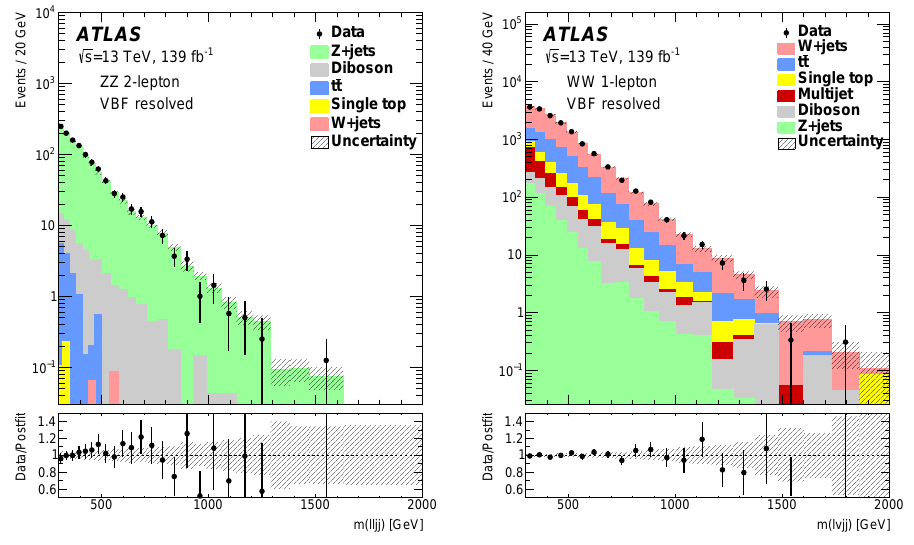
Figure 10. Comparisons of the observed data and the expected background distributions of m (cid:96)(cid:96) jj in the VBF resolved 2 lepton SR (left) and of m (cid:96) ν jj in the VBF resolved 1 − bottom panels show the ratios of the observed data to the background predictions. The hatched bands represent the uncertainties in the total background predictions, combining statistical and systematic